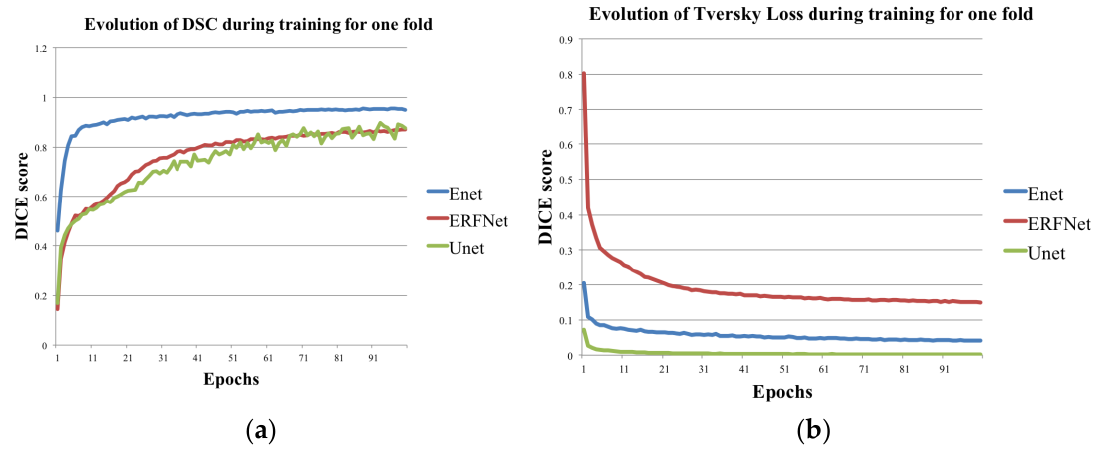
Figure 3. ( a ) Training DSC and ( b ) loss function Tversky loss plots for each of the three models for one fold.